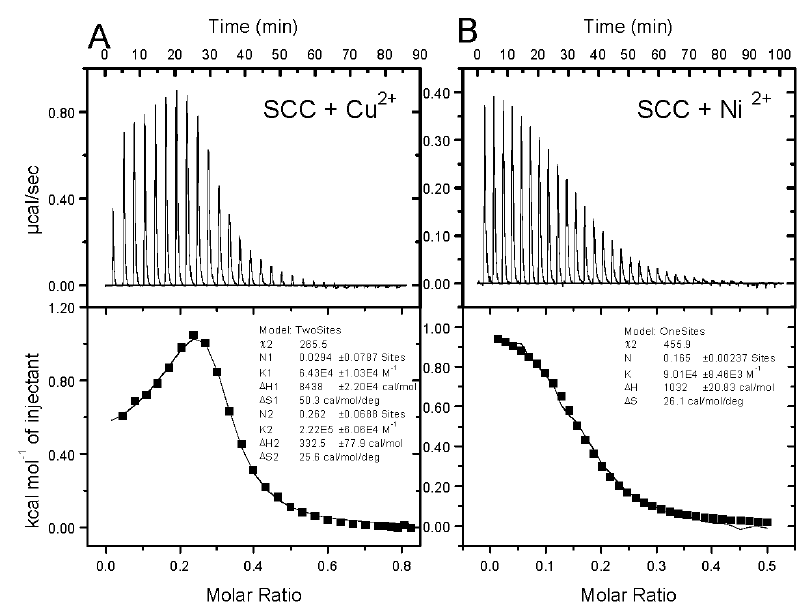
Figure 1. Binding isotherms for sodium copper chlorophyllin (SCC) titrated with copper and nickel ions. Titrations of ( A ) 0.76 mM SCC with 4.2 mM Cu(ClO 4 ) 2 and ( B ) 0.76 mM SCC with 1.89 mM Ni(ClO 4 ) 2 in H 2 O at 25 ◦ C were performed using an isothermal titration calorimetry (ITC) microcalorimeter. The integrated fitted curves show the experimental points with a sequential binding site function for SCC / Cu(ClO 4 ) 2 titration and with a one-site function for SCC / Ni(ClO 4 ) 2 titration. Table 1. Thermodynamic parameter of SCC/M 2+ complexation in water at 25 °C.